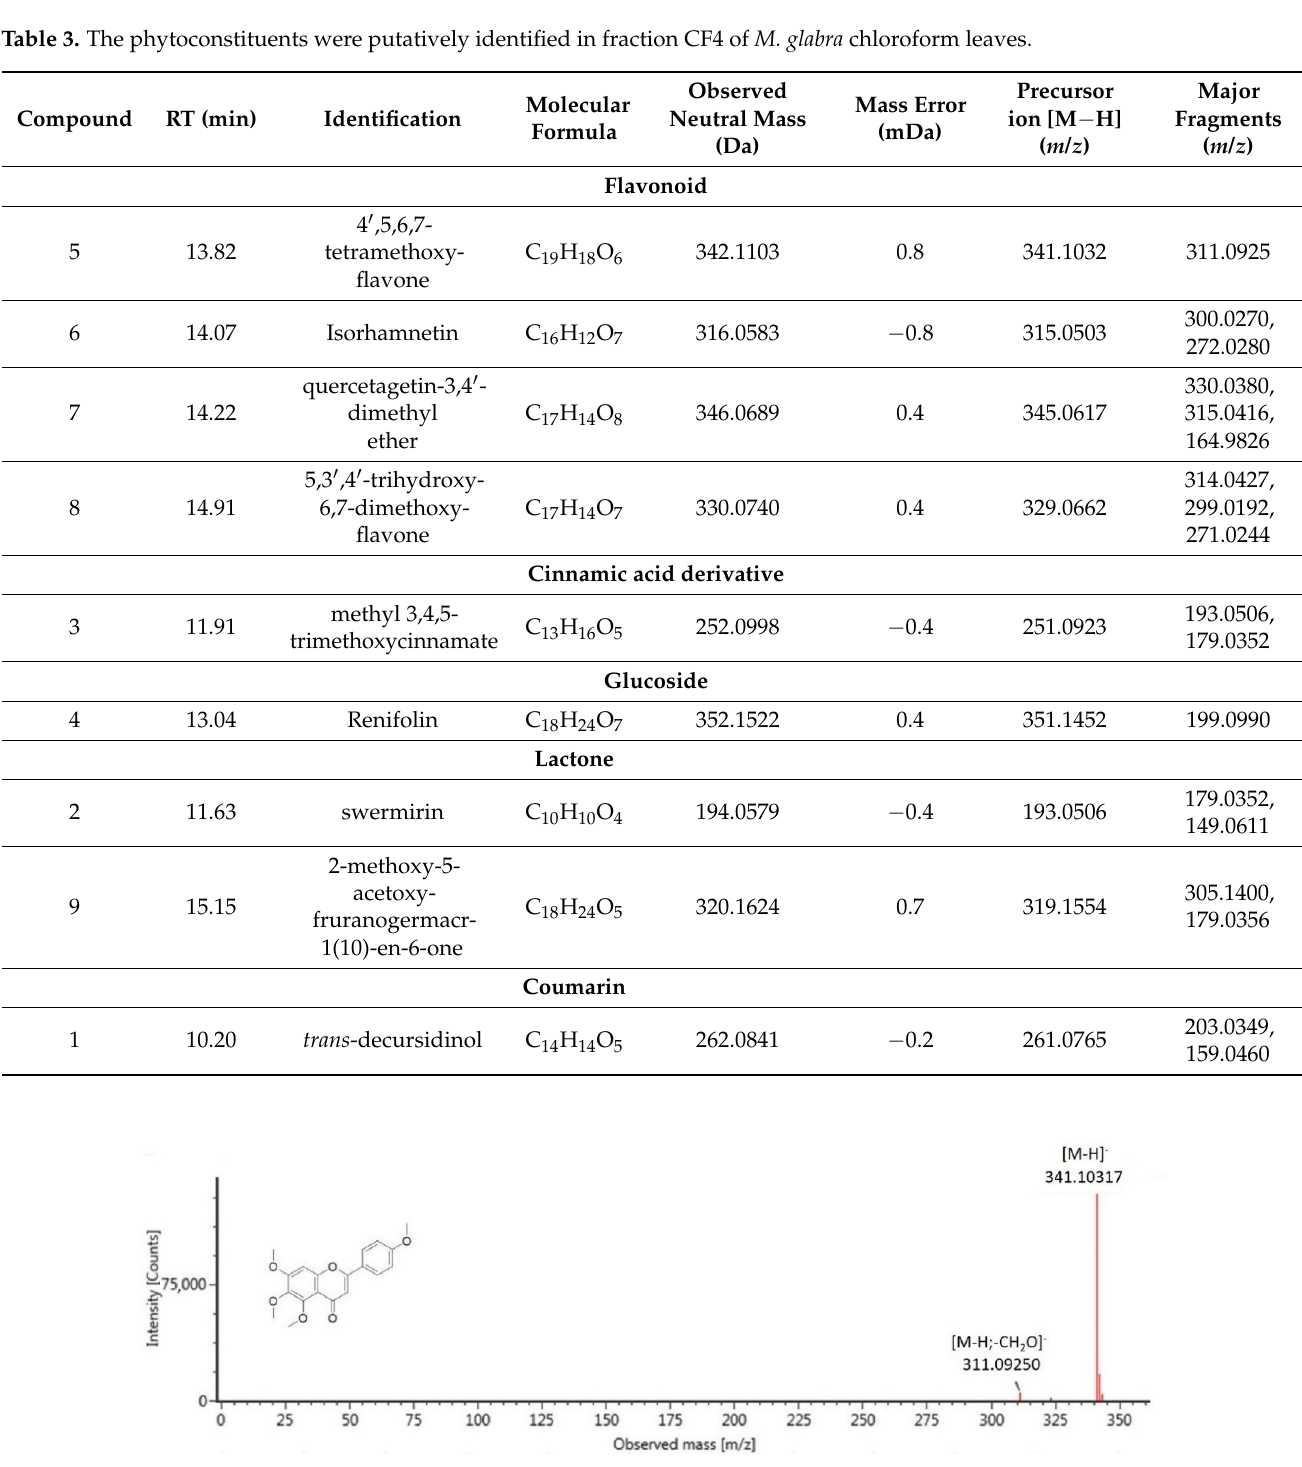
Table 3. The phytoconstituents were putatively identified in fraction CF4 of M. glabra chloroform leaves. Compound RT (min) Identification